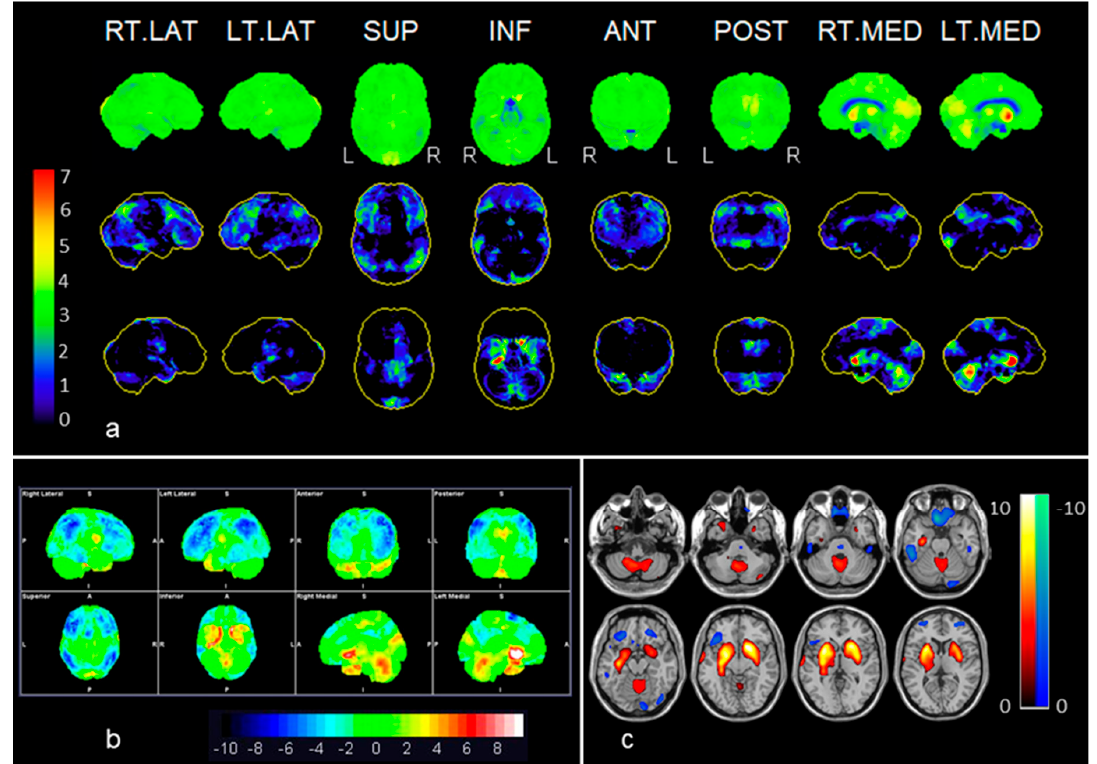
Figure 1. Example of anti-LGI-1 (case 2): ( a ) Neurostat: the first row shows surface projections of brain metabolism (visual assessment); the second row shows significant decreases in brain metabolism (red to green); and the third row shows significant increases (red to green) in brain metabolism as compared to an adjusted normal database. ( b ) syngo.via Database Comparison, and ( c ) Statistical Parametric Mapping (SPM 12). Statistical surface projections using Neurostat ( a ) and syngo.via Database Comparison ( b ) assessment distinguished better than SPM the frontal, lateral temporal and parietal hypometabolism, whereas hypermetabolic areas involving basal ganglia, cerebellar vermis and the medial aspect of the right temporal lobe were seen by the three methods. Color bars represent significant increases or decreases in brain metabolism compared to a normal database stratified by age. In the displayed Neurostat and SPM results, all the colored voxels represent statistical significance when compared to normal controls (Neurostat: increases and decreases in red to green; SPM: increases in, red to yellow, decreases in blue) whereas in the syngo.via Database Comparison, the significant voxels can be identified according to the SD color bar, 2 SD being the threshold of statistical significance (i.e., areas with green voxels are not significant). See also Table